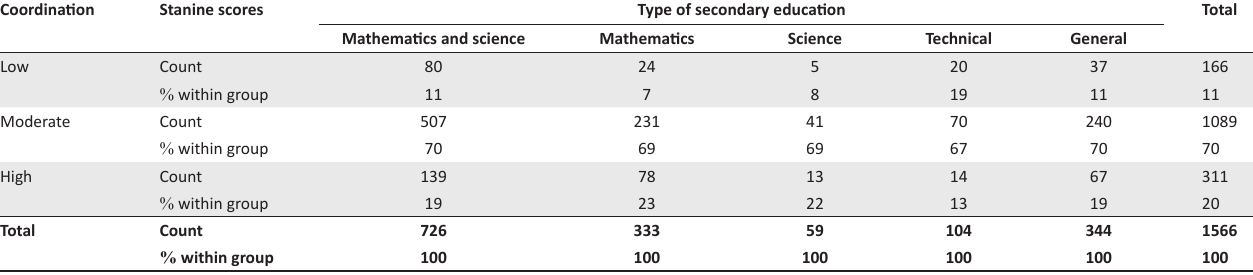
TABLE 3: Contingency table of observed frequencies for the coordination sub-test. Coordination